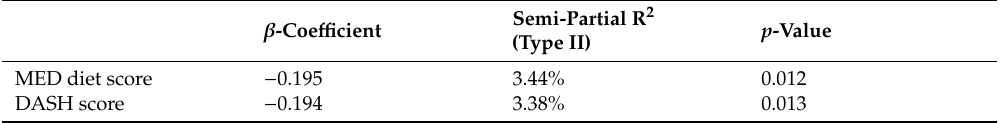
Table 6. Associations between diet scores and liver fat content (%) ( n = 136).